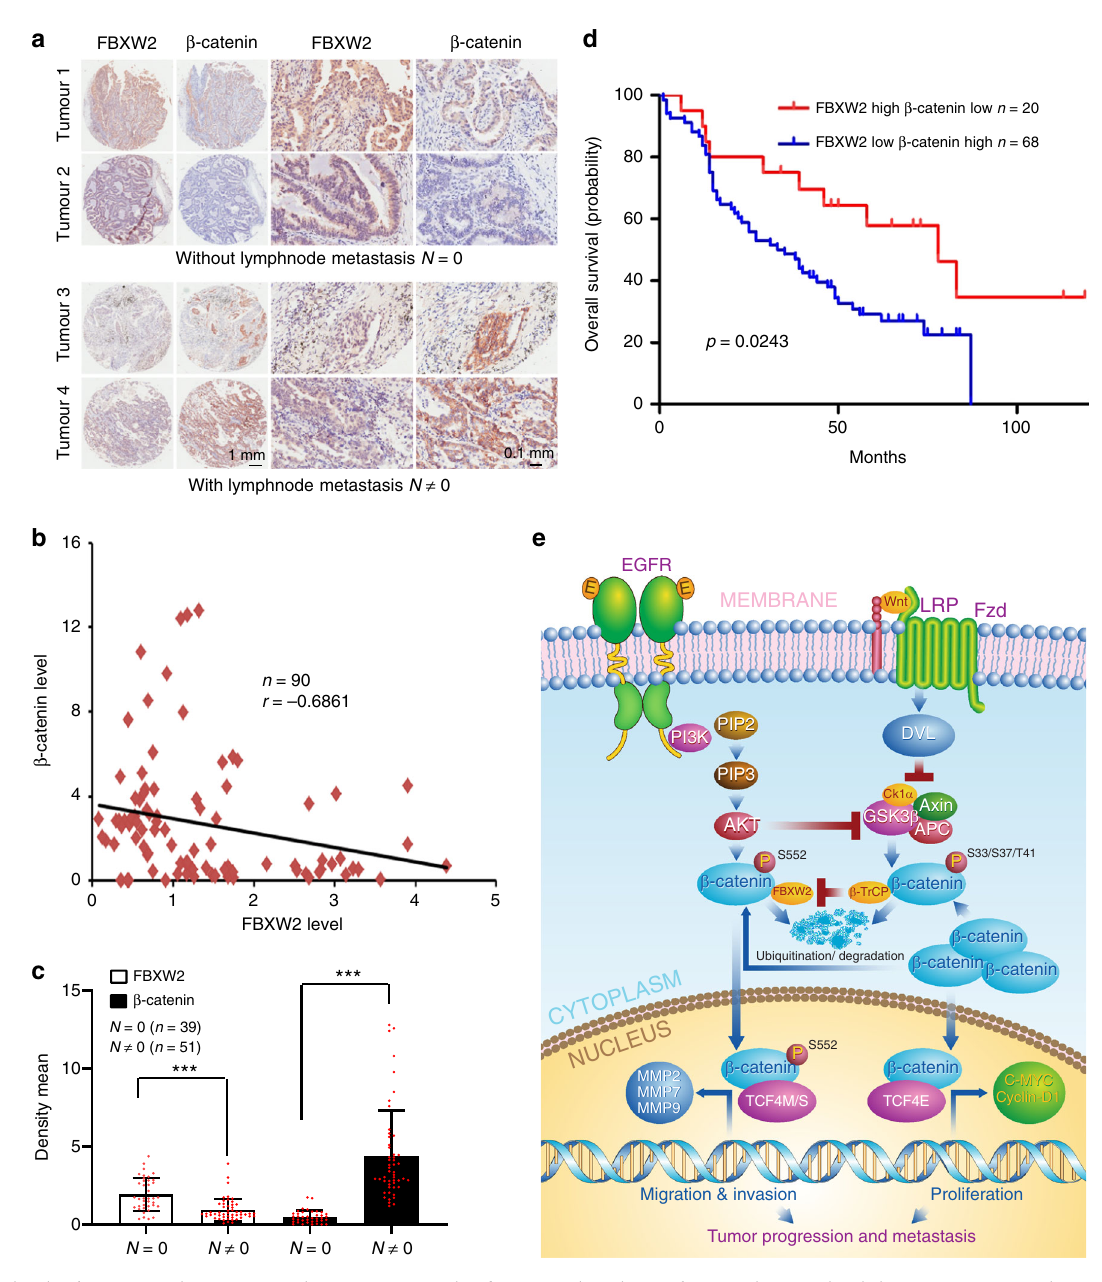
Fig. 7 The levels of FBXW2 and β -catenin predict patient survival. a , b A general tendency of inversed protein levels between FBXW2 and β -catenin in lung tumors: Human lung cancer tissue microarrays containing 90 human lung cancer specimens were immune-stained with anti-FBXW2 and anti- β -catenin antibodies. Representative staining pictures of tumors are shown ( a ). Quanti fi cation of the staining intensity was performed by semi-quantitative scoring with all 90 tumors ( r = – 0.6861 p < 0.001, Pearson correlation coef fi cient) ( b ). c The expression levels of FBXW2 are reduced, while the expression levels of β -catenin are increased in the tumors with lymph-node metastasis: The staining intensity of FBXW2 and β -catenin in tumors with or without lymph-node metastasis ( N = 0: without lymph-node metastasis, N ≠ 0: with lymph-node metastasis) were statistically analyzed. Data are shown as mean ± s.d. *** p < 0.001 (Student ’ s t- test). d The association of FBXW2 and β -catenin expression with overall survival in lung cancer patients. A total of 180 lung cancer tissue microarray samples were stained for FBXW2 and β -catenin levels. The Kaplan-Meier analysis was performed in 88 cancer samples showing an inverse correlation. The results showed that lower levels of FBXW2, coupled with higher levels of β -catenin, predict a worse overall patient survival ( p = 0.0243, log-rank test). e Working model. EGF activation of EGFR leads to activation of AKT1, which inactivates GSK-3 β to abrogate its binding with β -TrCP, but phosphorylates β -catenin at Ser552 to facilitate its binding with FBXW2 for subsequent ubiquitylation and degradation. In human cancer (e.g. lung cancer) with low level of FBXW2, phospho- β -catenin ser552 is not degraded and translocated, along with non-degraded wild type β -catenin, to the nucleus, and forms a complex with TCF4M/S or TCF4E, leading to transactivation of the genes encoding MMPs or c-Myc/Cyclin D1 for enhanced migration/ invasion and proliferation, respectively (see text for more